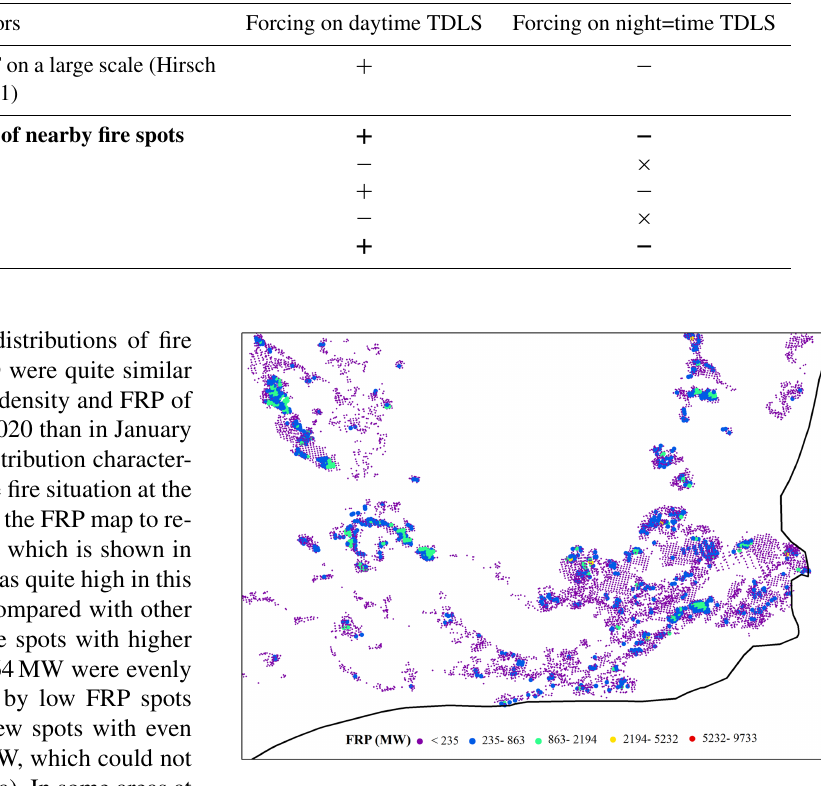
Figure 13. The detailed distribution of fire spots and their FRP in the fire centre during January